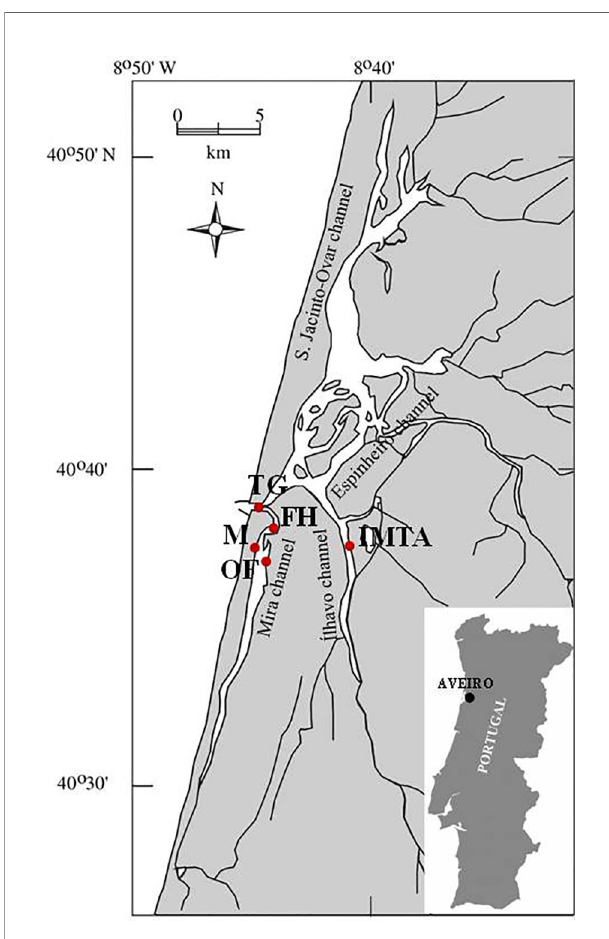
FIGURE 1 | Ria de Aveiro coastal lagoon and the four sampling sites located in the Mira channel and the fi fth sampling site located in I ́ lhavo channel, surveyed in the present study (red dots). TG, Tide Gauge; FH, Fishing Harbour; M, Marina; OF, Oyster Farm; IMTA, Integrated Multi-Trophic